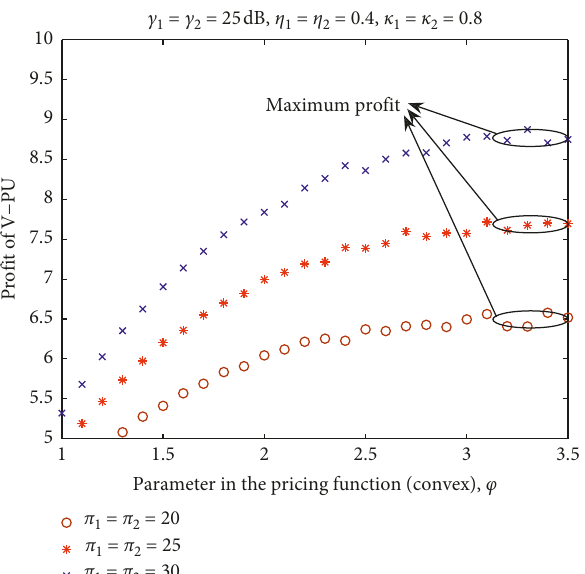
Figure 5: The profit of the V-PU vs. φ on spectrum